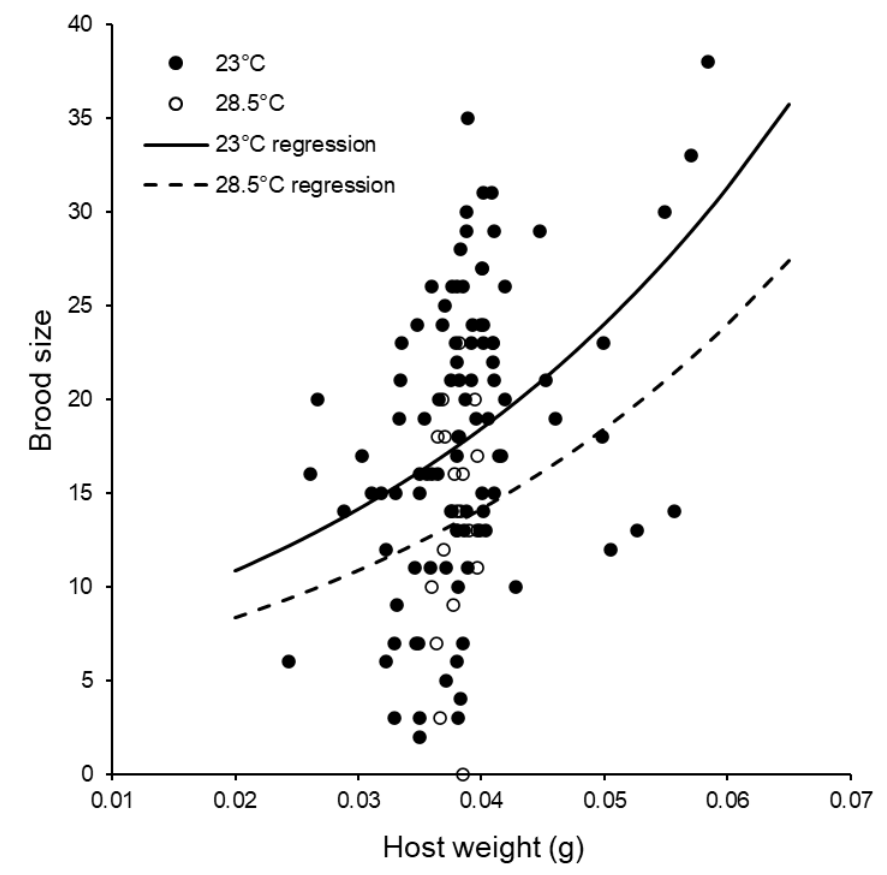
Figure 7. The influences of host weight and post-storage temperature on brood sizes produced by groups of females. The curves were fitted using log-linear ANCOVA (Brood size produced at 23 °C = antiLog e ((26.44 × host weight) + 1.857); Brood size produced at 28.5 °C = antiLog e ((26.44 × host weight) + 1.591)).